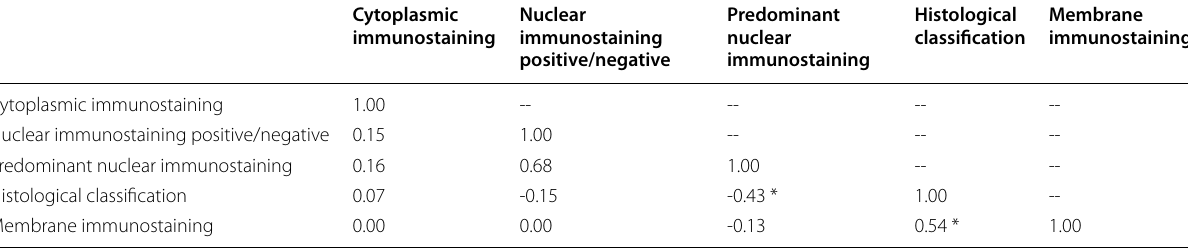
Table 1 Pearson correlation coefficient matrix for Ca 1.3 immunohistochemical staining correlating all the analysed parameters. V Histological classification was correlated positivity with membrane immunostaining and negativity correlated with nuclear